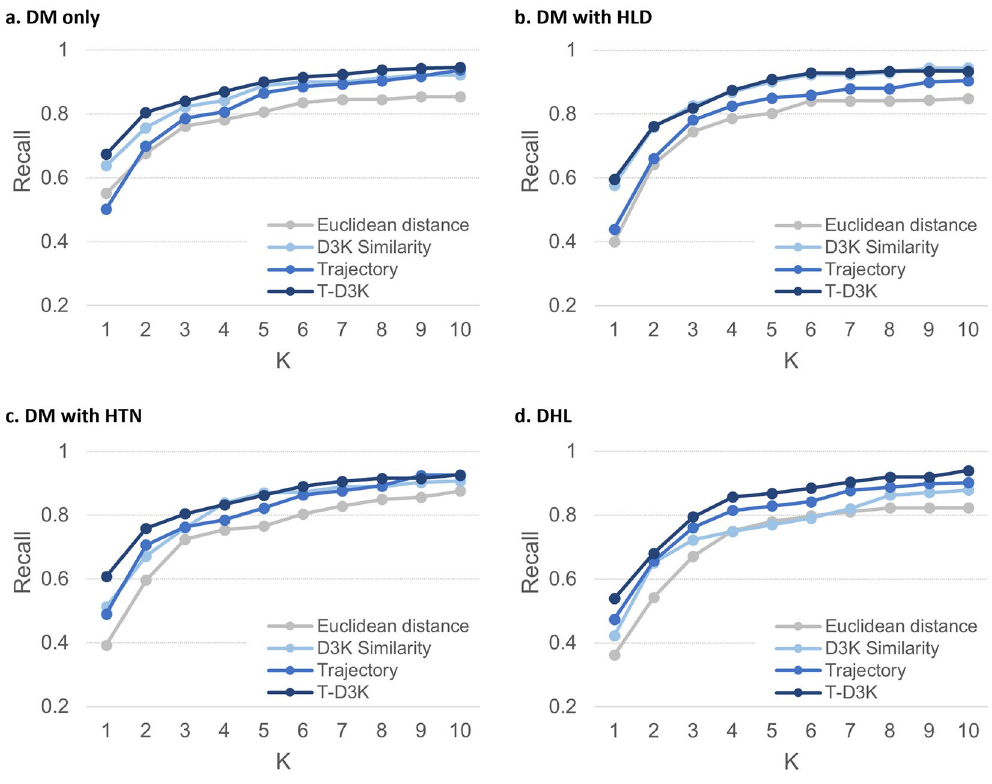
Figure 2. Recall for four groups of patients.